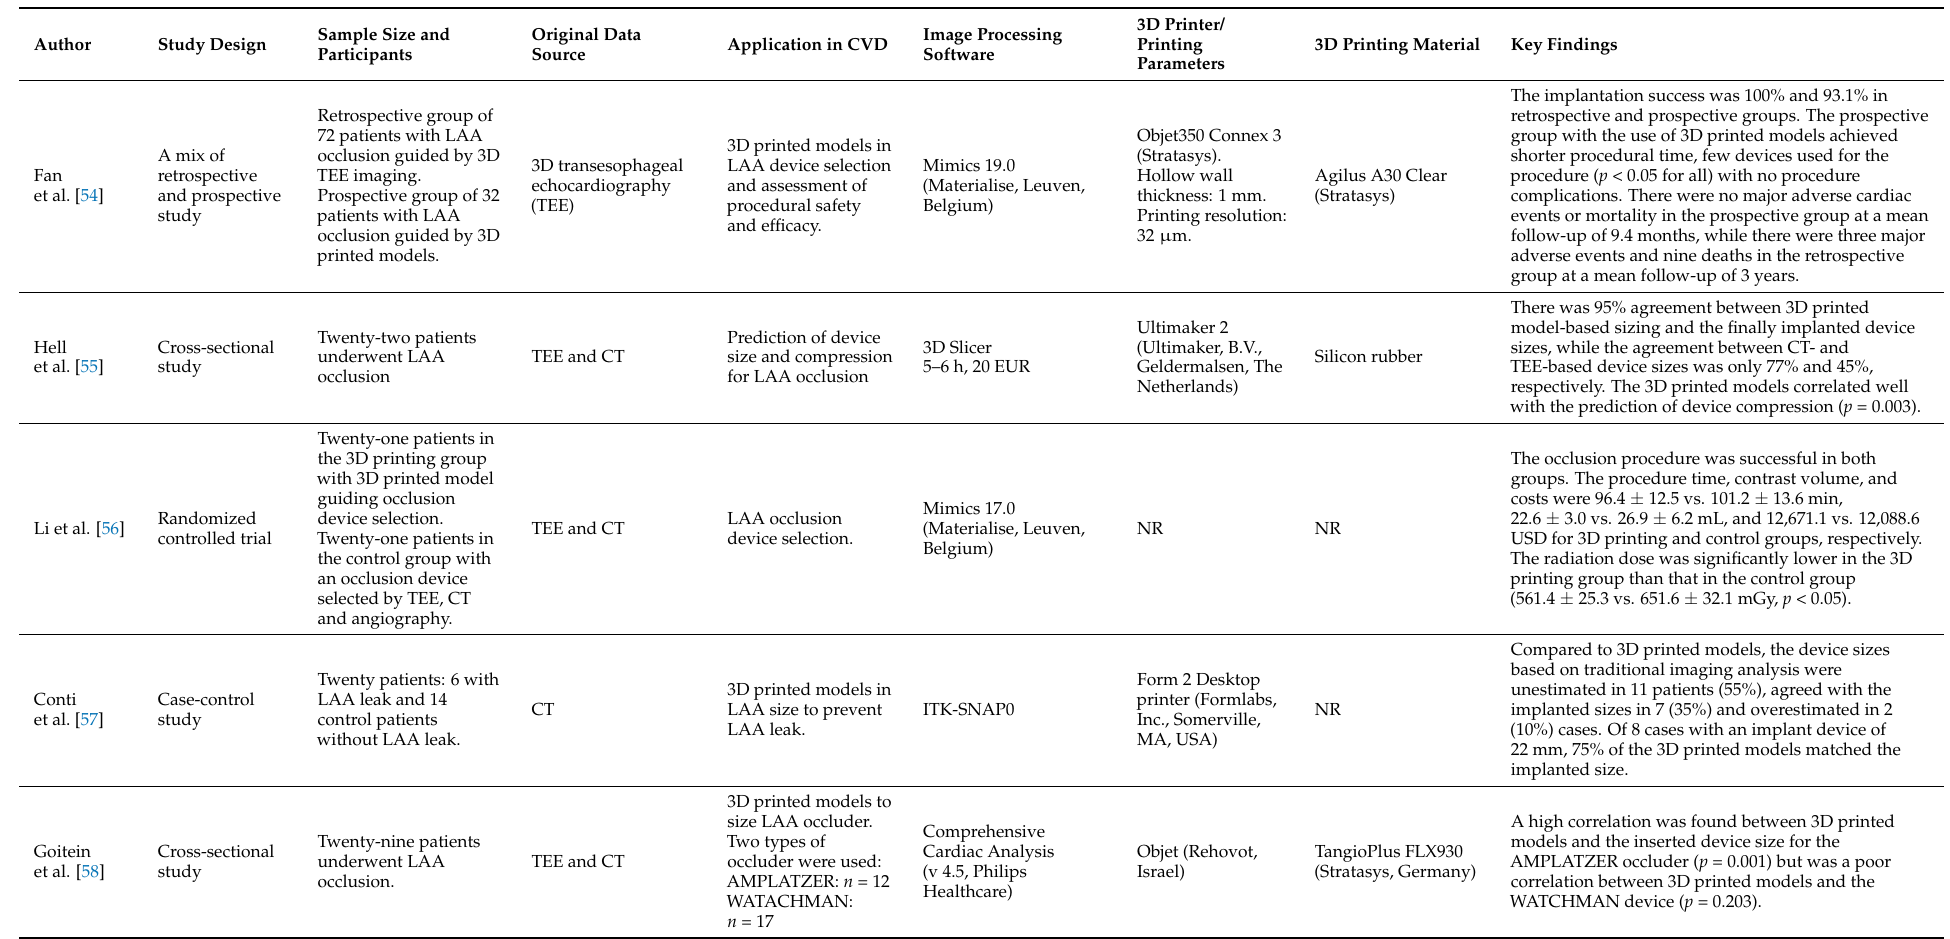
Table 4. Clinical application of 3D printed models in simulation of surgical or interventional